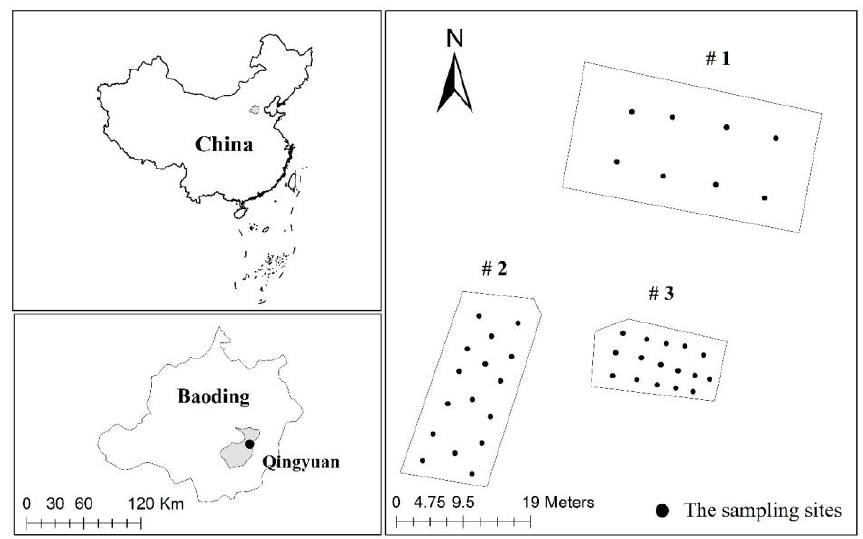
Figure 1. Sampling sites in a township metallurgy factory of Baoding, North China.